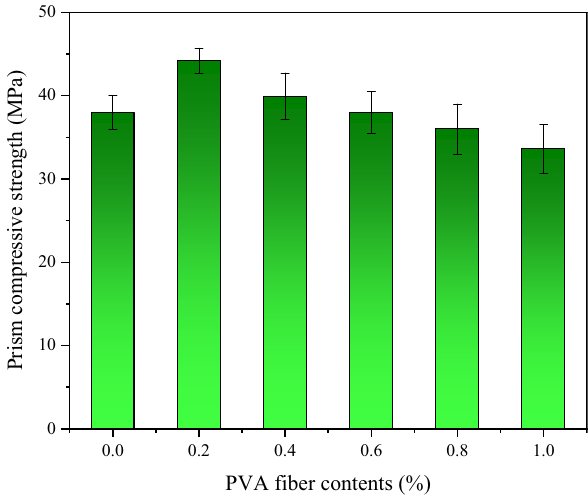
Figure 9: Prism compressive strength versus PVA fi ber